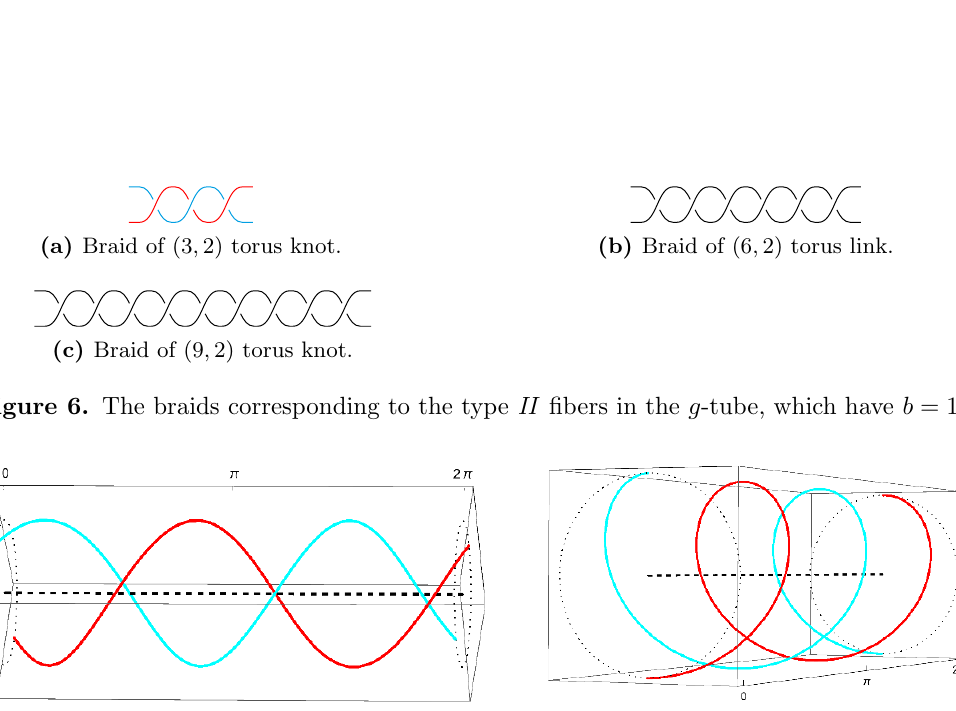
table 4a. Note that if a junction J is BPS, then charge will be the negative of the